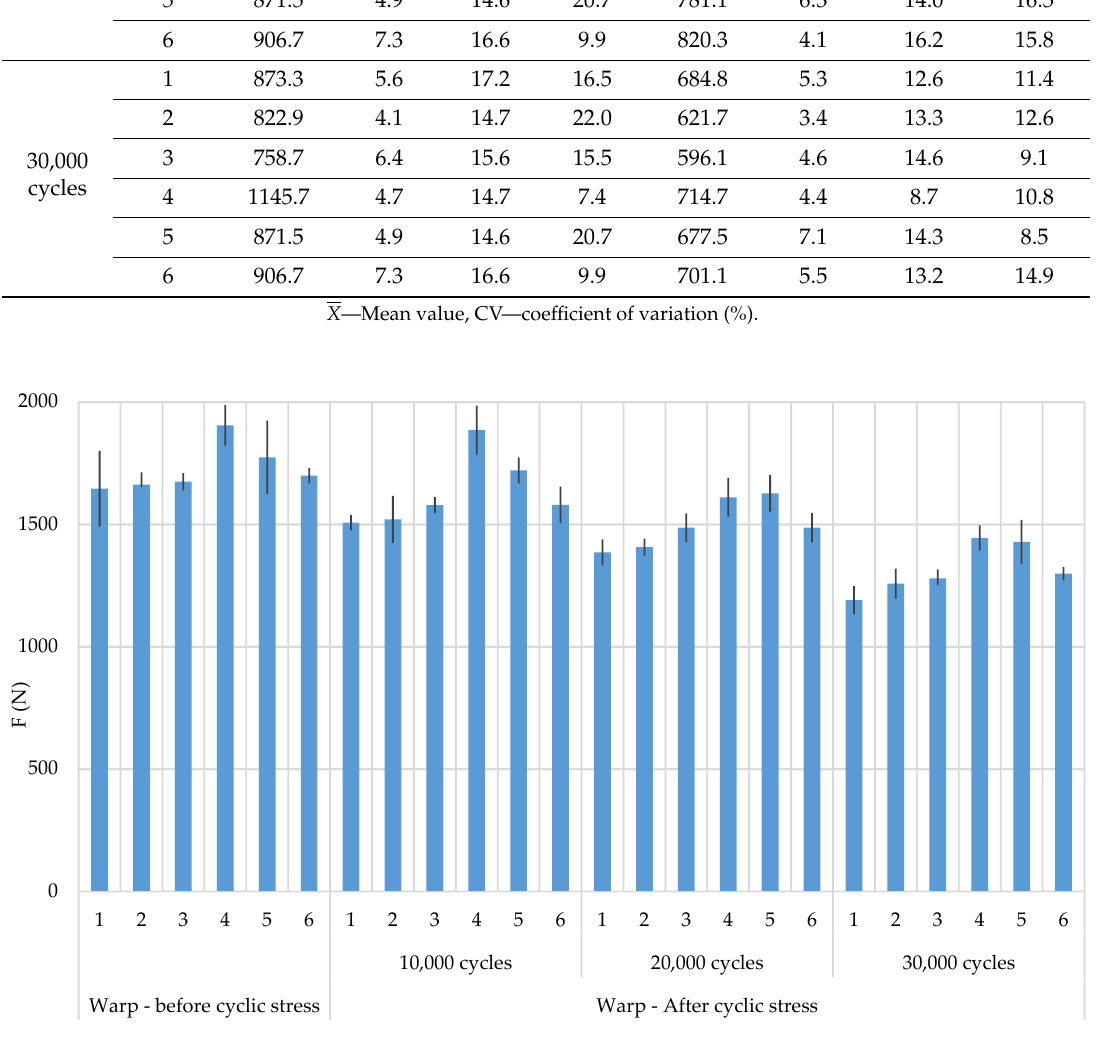
Figure 4. Breaking force of samples in warp direction, before and after subjection to cyclic loads, with error display.